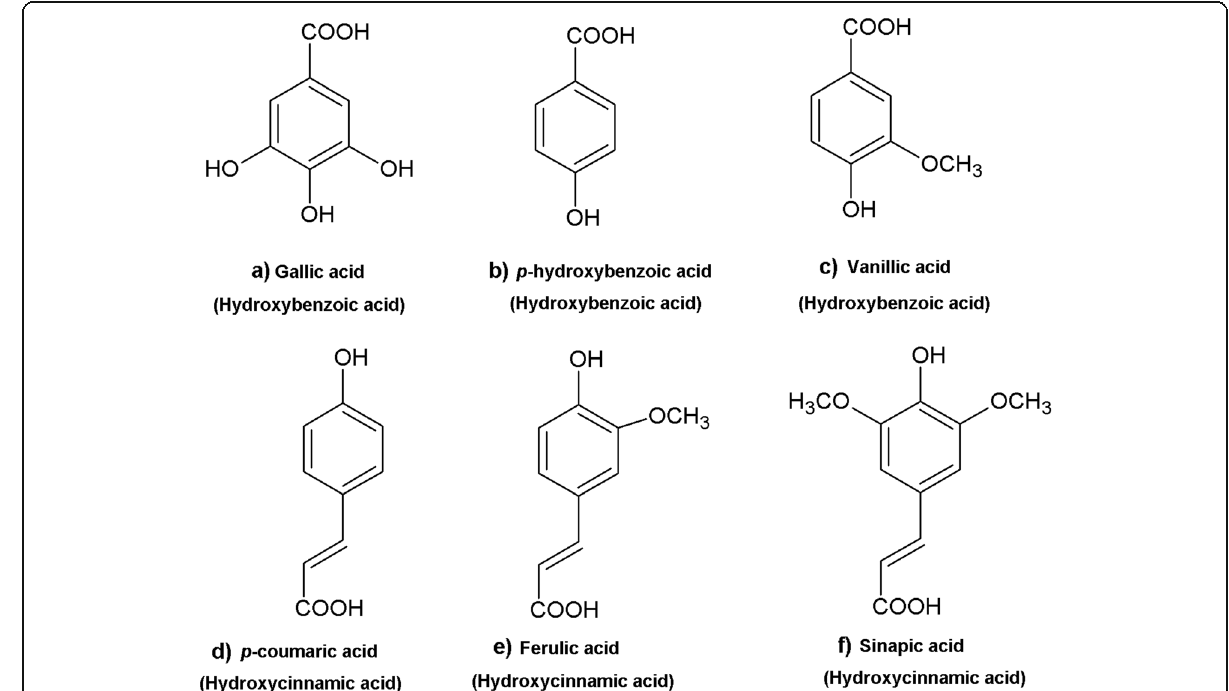
Fig. 1 Chemical structures of phenolic compounds present in cereal and millet